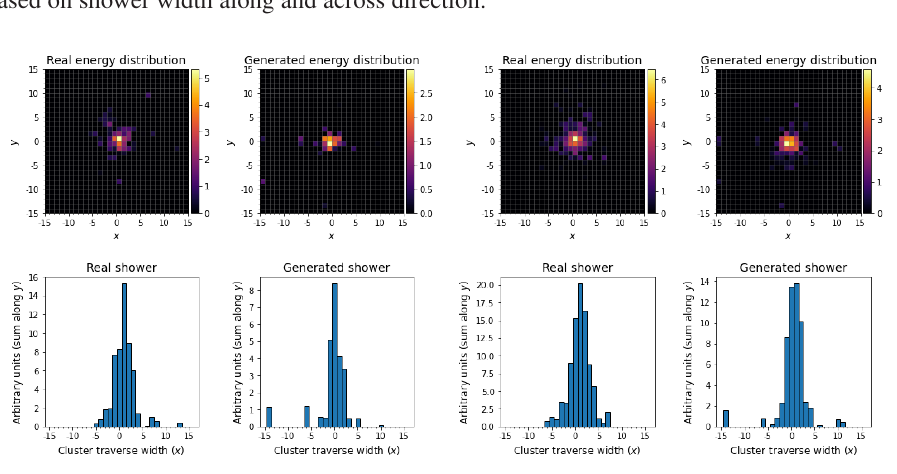
Figure 3: WGAN trained on log energies generated samples example.